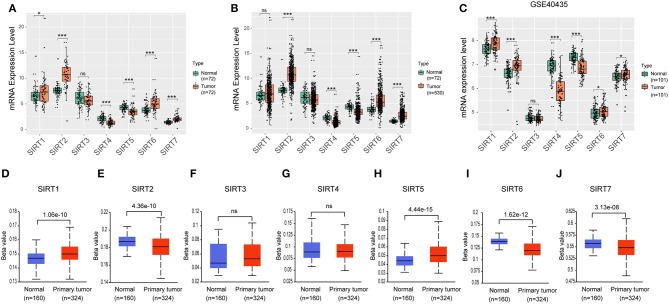
Expression level of sirtuins in KIRC. Boxplots show sirtuins expression in normal tissues compared with paired cancer tissues (A), or unpaired KIRC tissues (B). (C) Boxplots show sirtuins expression in normal and KIRC tissues from GSE40435. (D–J) Promoter methylation status of sirtuins in KIRC (*P < 0.05, ***P < 0.001).